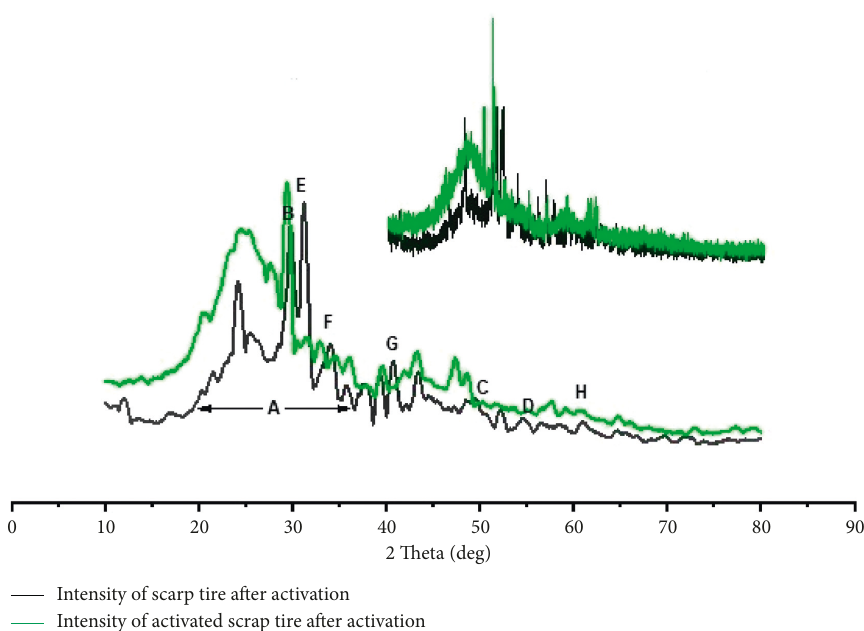
Figure 4: XRD analysis of scrap tire after activation (black color) and after adsorption (green